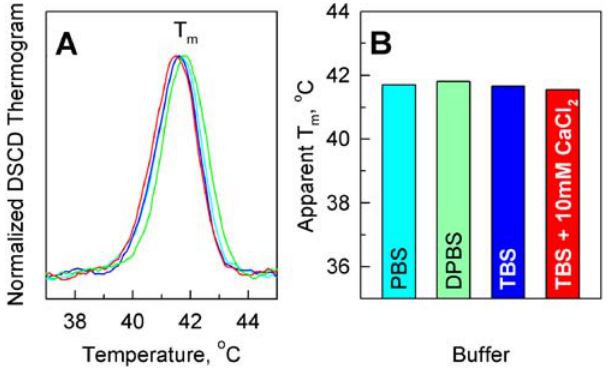
Figure 2. Divalent ions do not affect thermal stability of procollagen. Normalized denaturation thermograms (A) and apparent T m (B) measured by DSCD at 0.05 u C/min scanning rate in PBS, DPBS (PBS with 1 mM CaCl 2 and 0.5 mM MgCl 2 ), TBS (50 mM Tris, 150 mM NaCl), and TBS with 10 mM CaCl 2 . All buffers had neutral pH 7.1–7.5. The thermograms in A have the same colors as the corresponding bars in chart B.